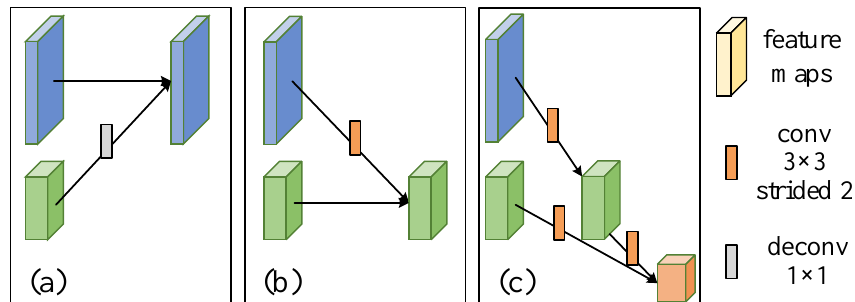
Figure 6. Three parts of the integrated unit. Different resolution feature maps are fused by the output feature maps of second and third stage. The blue blocks are the high-resolution feature maps. The green blocks are the low-resolution feature maps. The orange block is the lower resolution feature maps. ( a ) The high-resolution features are maintained. ( b ) The low-resolution features are maintained. ( c ) The lower resolution features are